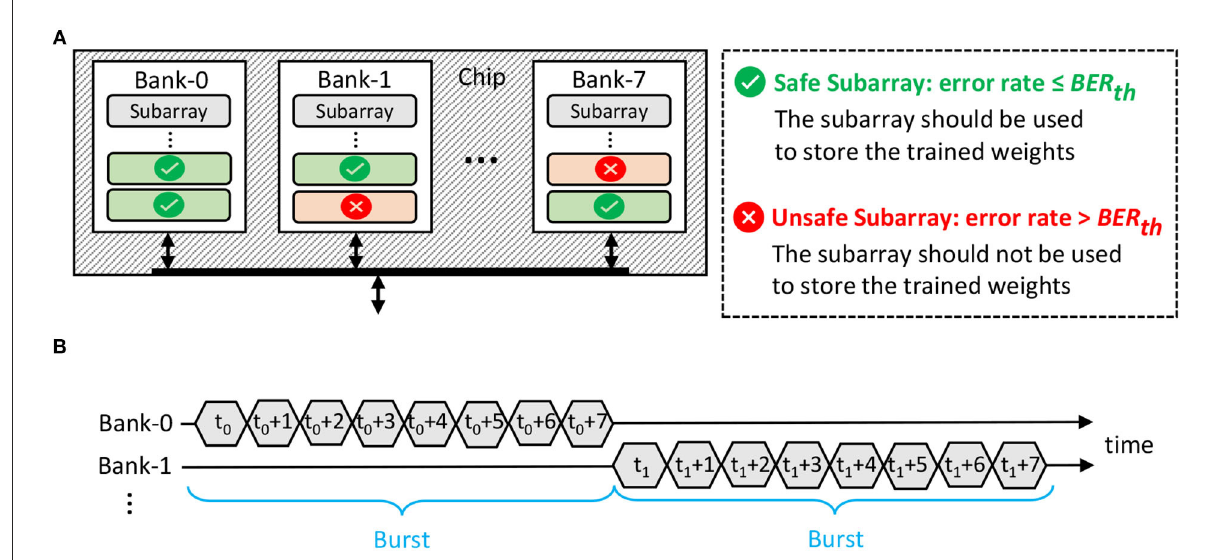
FIGURE7 (A) Our proposed DRAM mapping policy, leveraging subarray-level granularity. (B) The timing diagram of the DRAM multi-bank burst